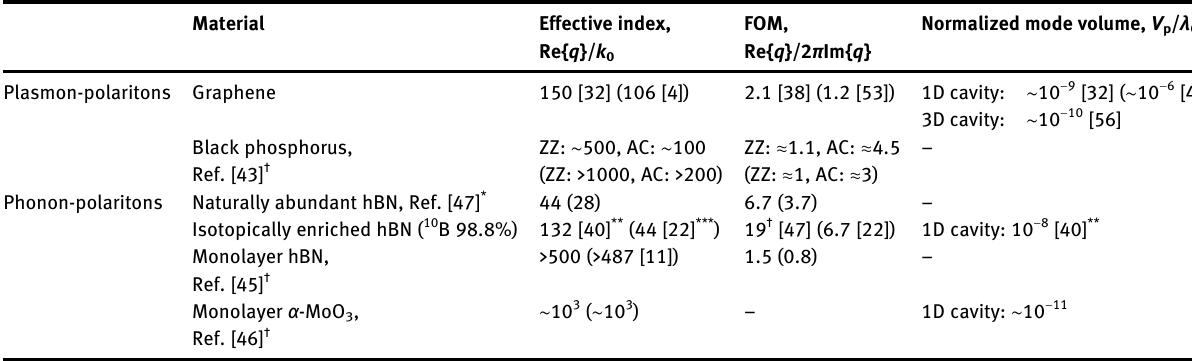
Table  : Limiting properties of mid-IR image polaritons: experimentally measured and theoretically predicted values of the effective index, FOM, and normalized volume of cavity-localized modes. Values reported for the conventional polariton counterparts are also presented in parentheses; hBN and α -MoO  values are for their second Reststrahlen band and fundamental mode unless stated